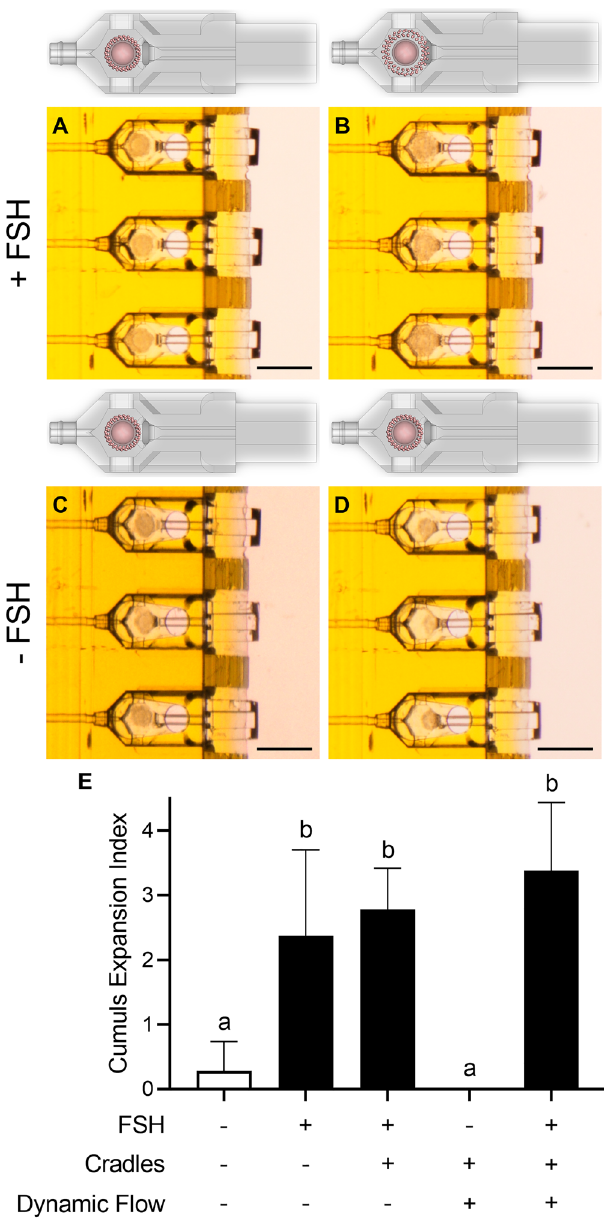
Figure 7. Cumulus expansion in the dynamic flow device in the presence and absence of recombinant human follicle stimulating hormone (rhFSH; Scale bars = 300 µm; 3 reps, n = 8). ( A , C ) Mouse cumulus-oocyte- complexes (COCs) before flow begins; ( B ) Mouse COCs after exposure to rhFSH via dynamic flow following 16 h of culture; ( D ) Mouse COCs after no exposure to rhFSH via dynamic flow following 16 h of culture; ( E ) Mean cumulus expansion index (CEI; ± SD) of cumulus expansion following exposure to rhFSH with groups containing cradles housing the COCs in the cradles and dynamic flow groups in flow conditions; Kruskal– Wallis test with Dunn’s multiple comparisons test with significance accepted at p < 0.05, with significant differences denoted by different letters above each